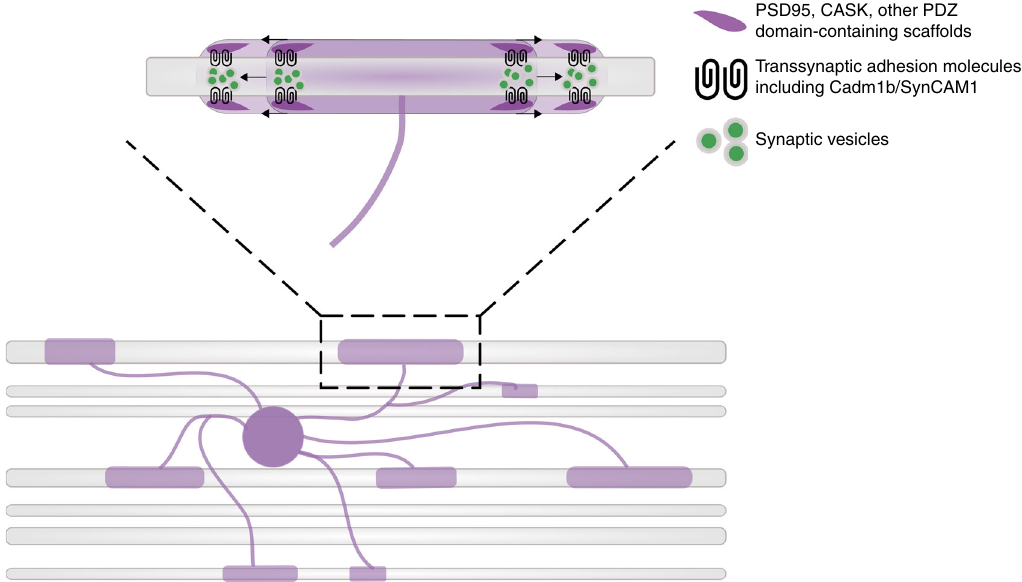
Fig. 7 Working model of adhesion-promoted sheath growth. PSD95 and other PDZ domain-containing scaffolds expressed by oligodendrocytes, including CASK and Dlg1, anchor transsynaptic adhesion molecules that adhere to and induce presynaptic assembly in the ensheathed axon. The accumulation and exocytosis of synaptic vesicles at ensheathment sites promotes the elongation of nascent sheaths, possibly via neurotransmitter- and/or neurotrophin- induced intracellular signaling in the